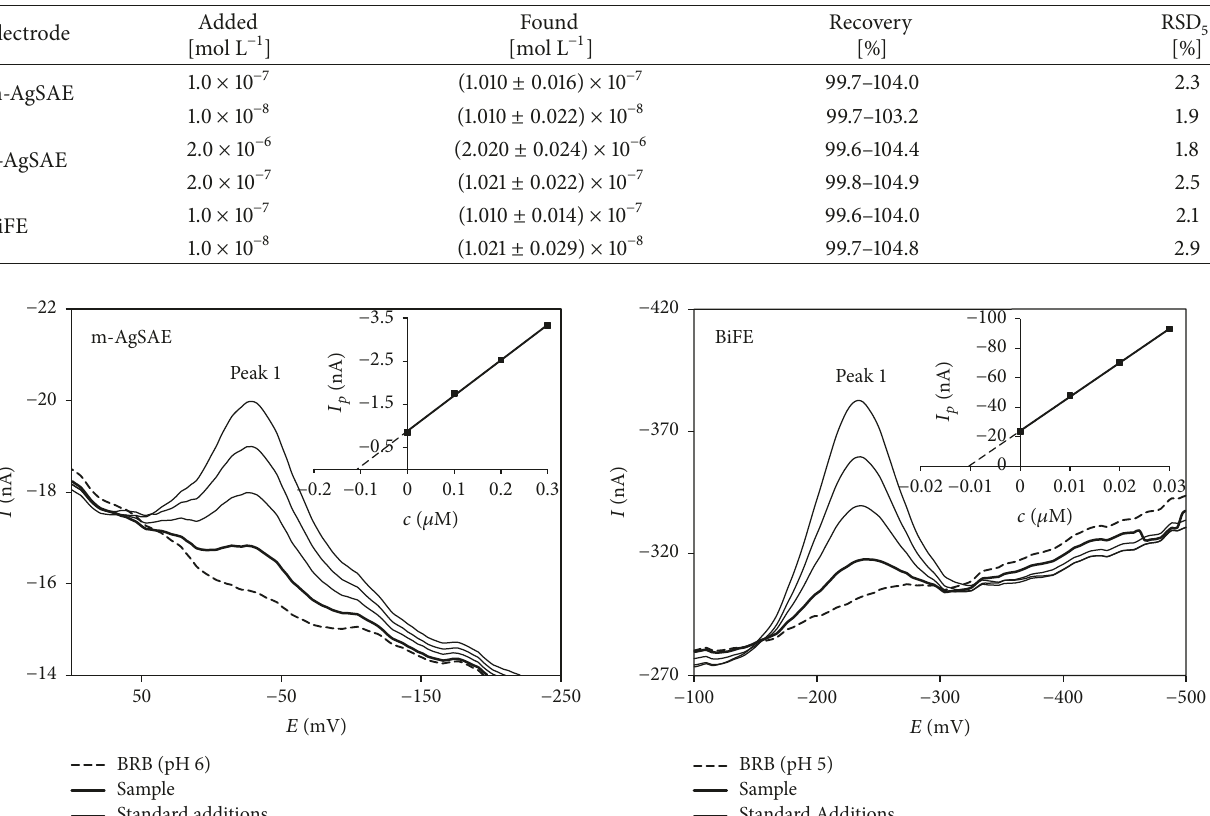
= − 1300 mV, V = 40 mVs −1 , pulse height = − 50 mV (BiFE), − 60mV (AgSAEs), pulse width fin = +200 mV, and 𝑡 = 0–50 s (in dependence on 𝑐 )); 𝛼 = 0.05. acc acc DAN